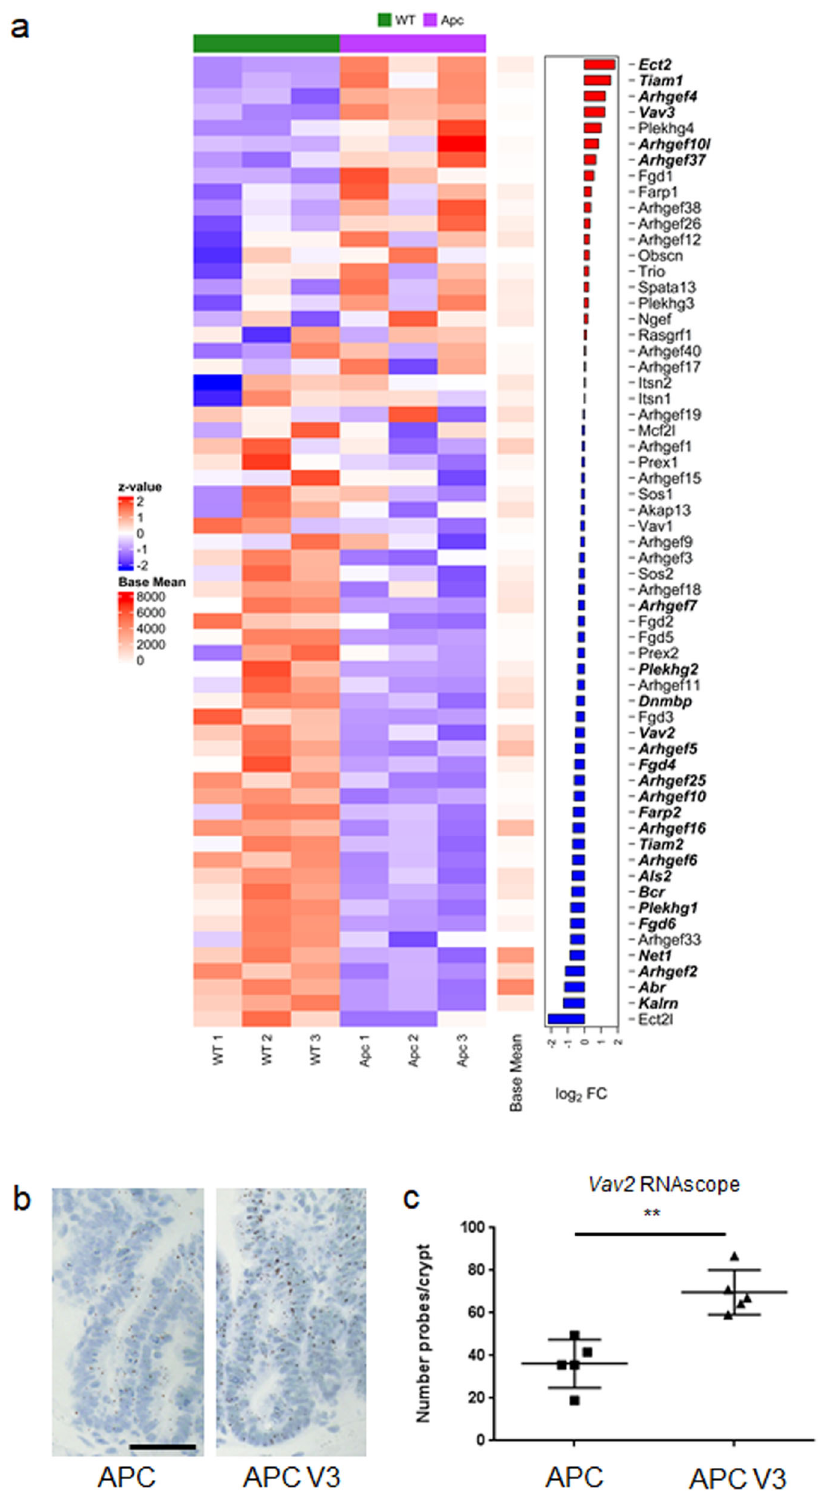
Fig. 2 VAV3 and TIAM1 are upregulated following APC loss. a Heatmap derived from RNA-seq analysis comparing whole tissue from wild-type ( Vil- CreER T2 ) and APC intestines ( Vil-CreER T2 Apc fl /fl ) n = 3 biologically independent animals for both APC and WT intestinal tissue. Log 2 FC of GEF expression displayed on the right, genes signi fi cantly deregulated displayed in bold (FDR < 0.05) displayed in bold. b RNAscope of Vav2 in the intestinal epithelium of Vil-CreER T2 Apc fl /fl (APC) and Vil-CreER T2 Apc fl /fl , Vav3 − / − (APC V3) mice, Scale bar represents 100 μ m. c Quanti fi cation of Vav2 RNAscope from Vil- CreER T2 Apc fl /fl and Vil-CreER T2 Apc fl /f l Vav3 − / − intestines. N = 5 biologically independent animals for each genotype. P = 0.0079 as determined by a two- tailed Mann – Whitney test. Data are presented as mean values ±SD.